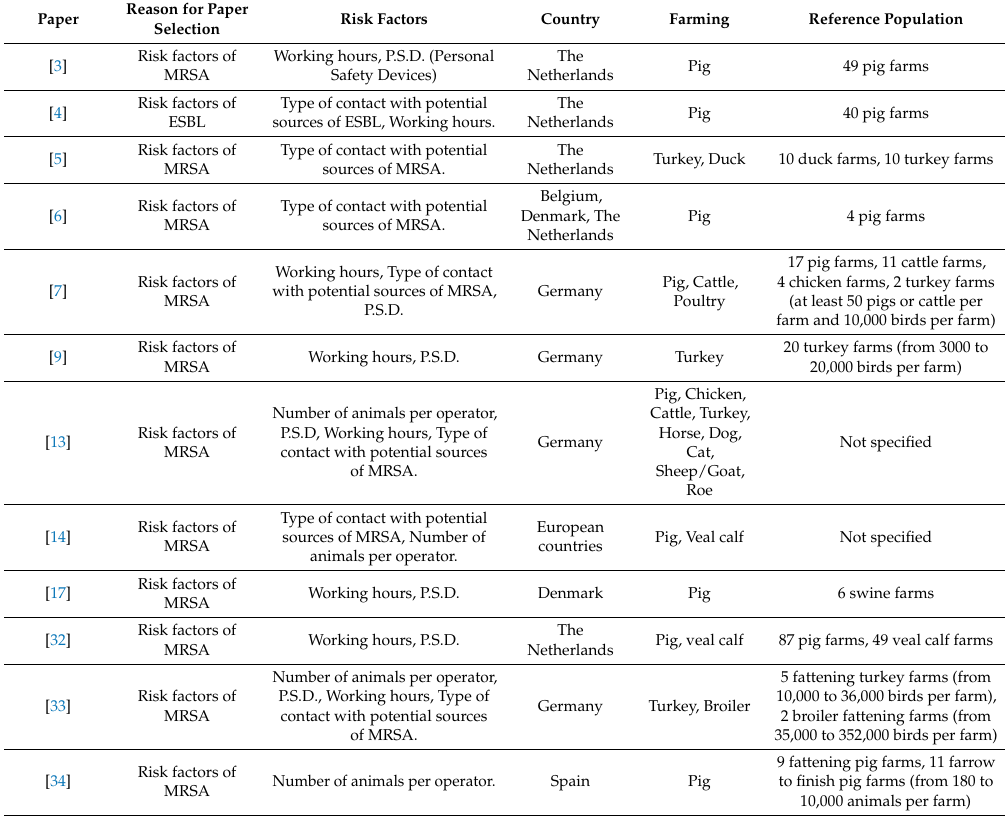
Table 2. Main characteristics of included papers for risk factors of MRSA and ESBL for farm